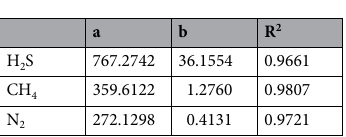
Table 4. Langmuir parameter of adsorption energy at 298